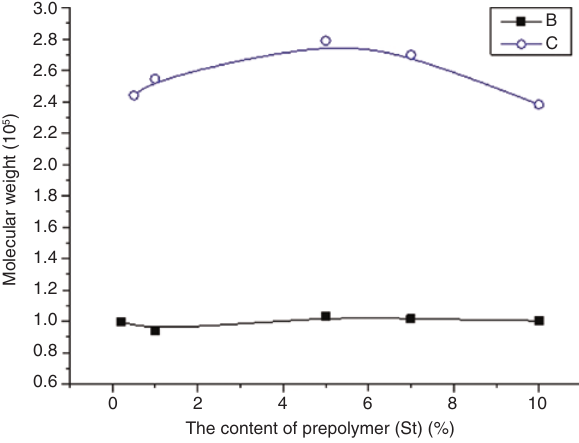
Figure 8: The relationship between molecular weight and the concentration of prepolymer (St). Curve B – sample without adding a-hydroxylethyl ferrocene, curve C – sample adding a-hydroxylethyl